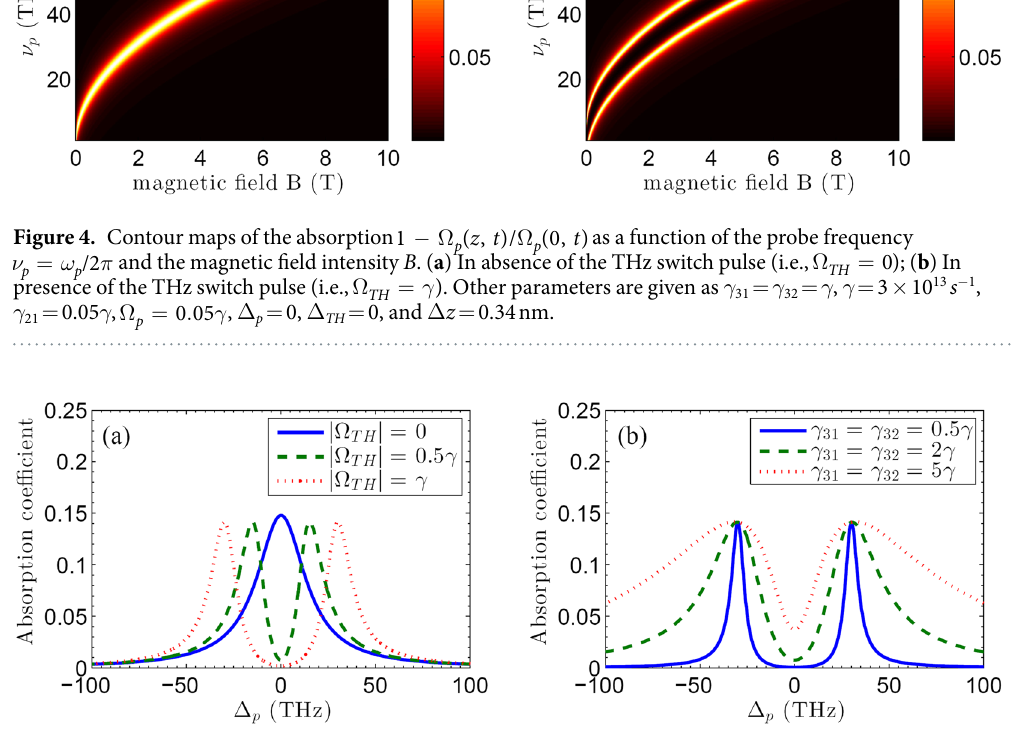
Figure 5. ( a ) The absorption coefficient − Ω Ω z t t 1 ( , )/ (0, ) as a function of the frequency frequency Δ p p p (THz) with γ 31 = γ 32 = γ for different values of Ω , i.e., Ω = 0 (solid line), γ Ω = . 0 5 (dashed line), and TH TH TH γ Ω = 1 (dotted line), respectively. ( b ) The absorption coefficient − Ω Ω z t t 1 ( , )/ (0, ) as a function of the TH p p frequency frequency Δ p (THz) with γ Ω = for different values of γ 31,32 , i.e., γ 31 = γ 32 = 0.5 γ (solid line), TH = γ = 2 γ (dashed line), and γ = γ = 5 γ (dotted line), respectively. Other parameters are given as B = 3 T, γ 31 32 31 32 = 0.05 γ , γ Ω = . 0 05 γ = 3 × 10 13 s − 1 , γ , Δ TH = 0, and Δ z = 0.34 21 p